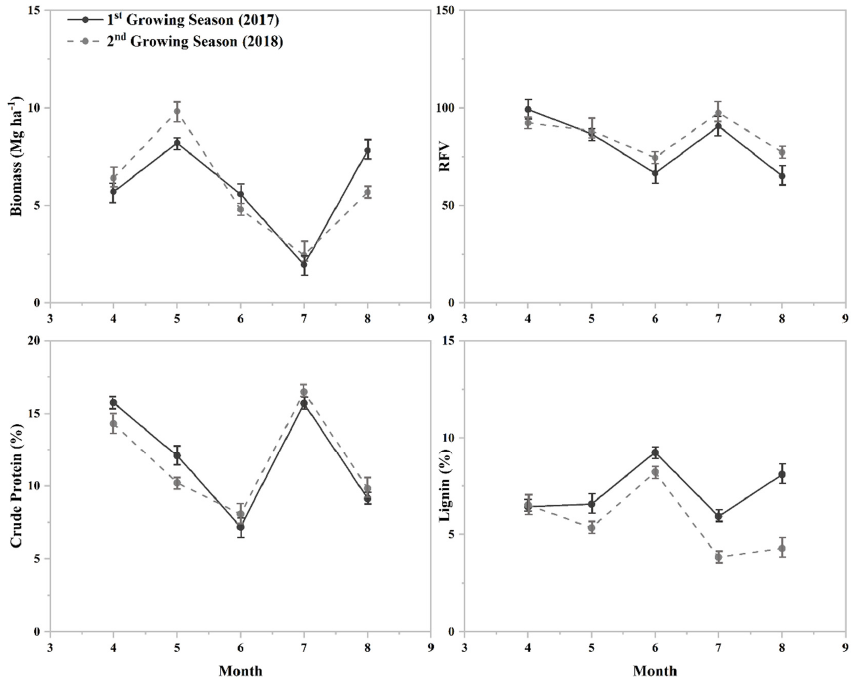
Figure 6. Evolution of biomass, relative feed value (RFV), crude protein (CP) concentration, and